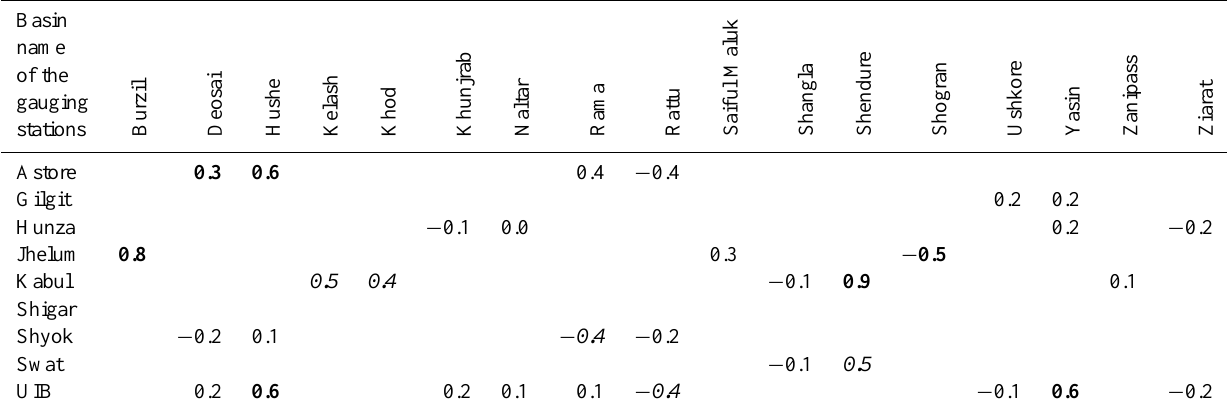
Table 12. Correlation coefficients for the estimated SWE (accumulated precipitation during periods when temperatures remained below zero), with the summer discharge ( Q ) at the nearby or corresponding gauging stations. Note: values significant at the 95% level are marked in bold, and at the 90% level in italic.